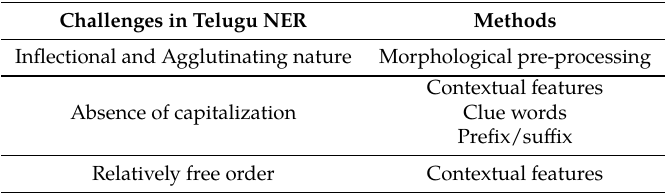
Table 5. Methods to handle the challenges in the Telugu language for named entity recognition